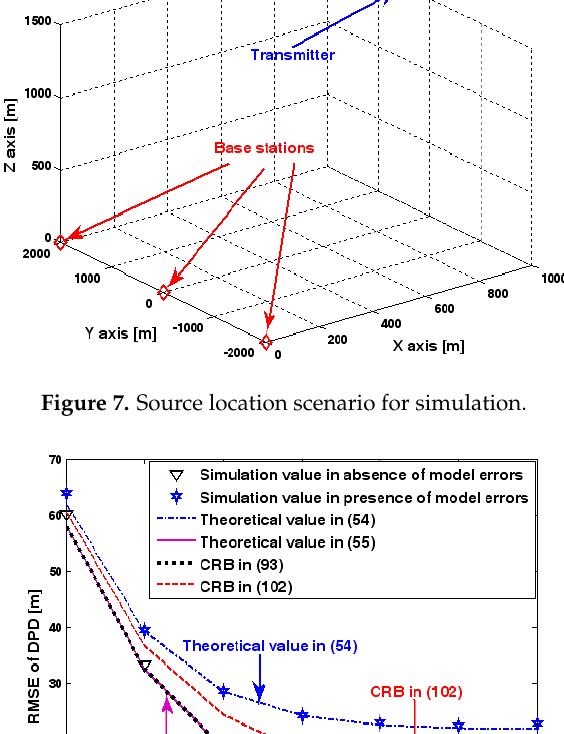
Figure 9. RMSE of DPD as a function of standard deviation of sensor gain perturbation. Figure 10. RMSE of DPD as a function of number of array elements.